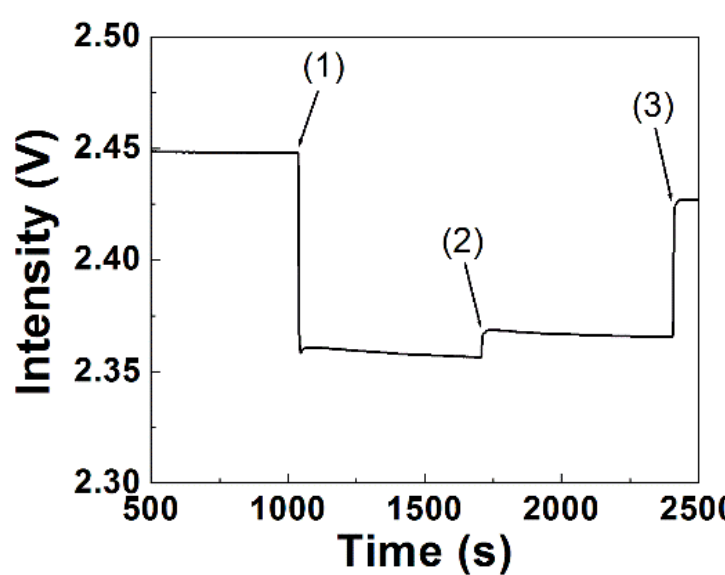
Figure 4. Typical real-time sensorgram during the surface activation process of aptamer NP-A48. Steps 1, 2, and 3 indicate loading of first EDC/NHS solution, second EDC/NHS solution, and ultrapure water, respectively.